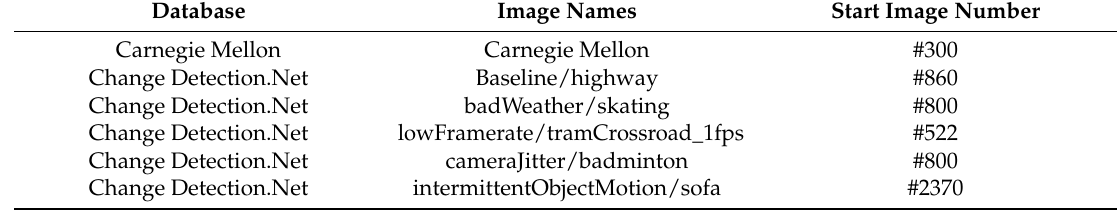
Table 3. Selected images and the start time of detection.